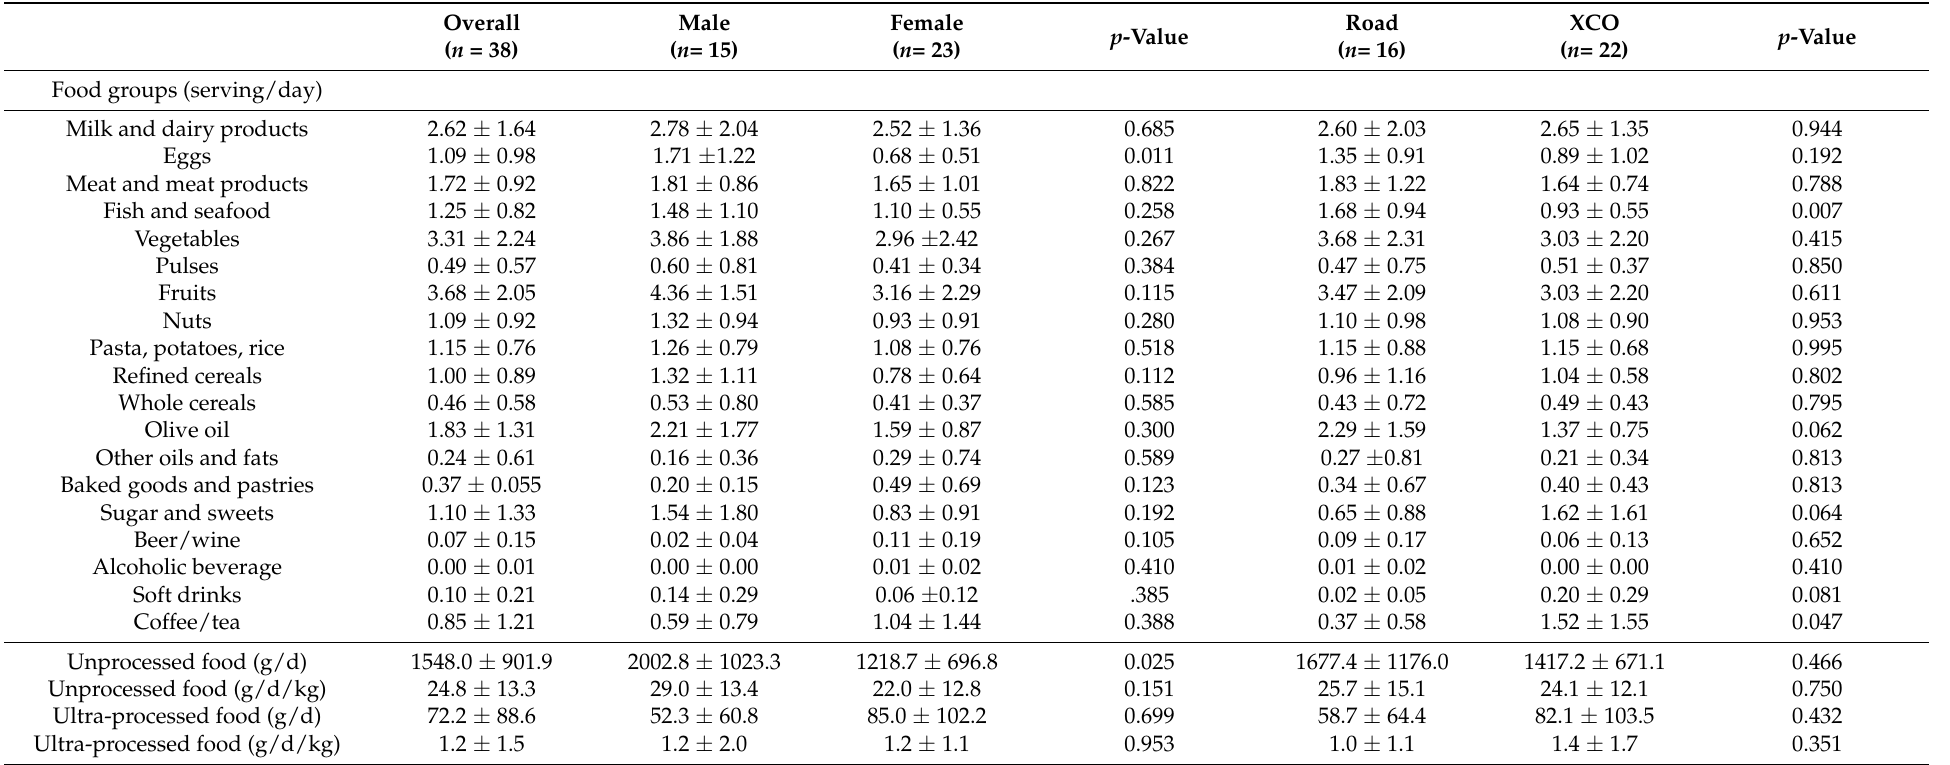
Table 4. Consumption of each food group according to sex and discipline during the complete